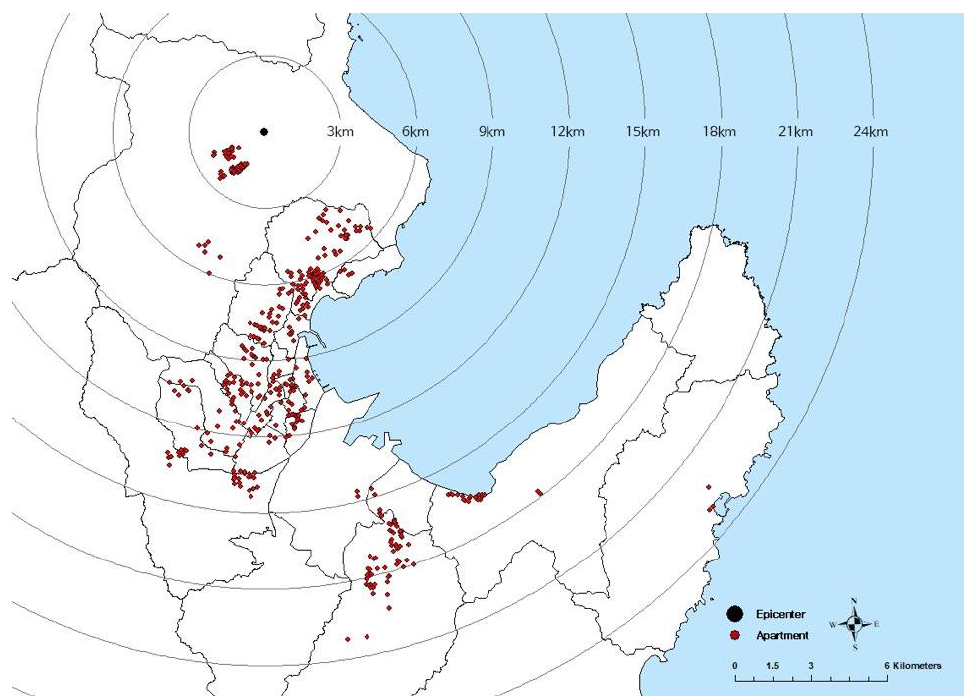
Figure 1. The distribution map of Pohang apartments for this study.